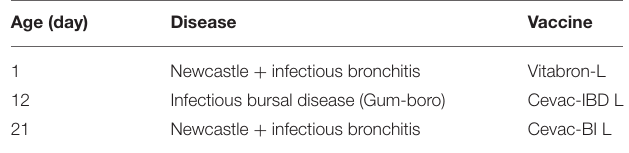
TABLE 1 | Vaccination program of the